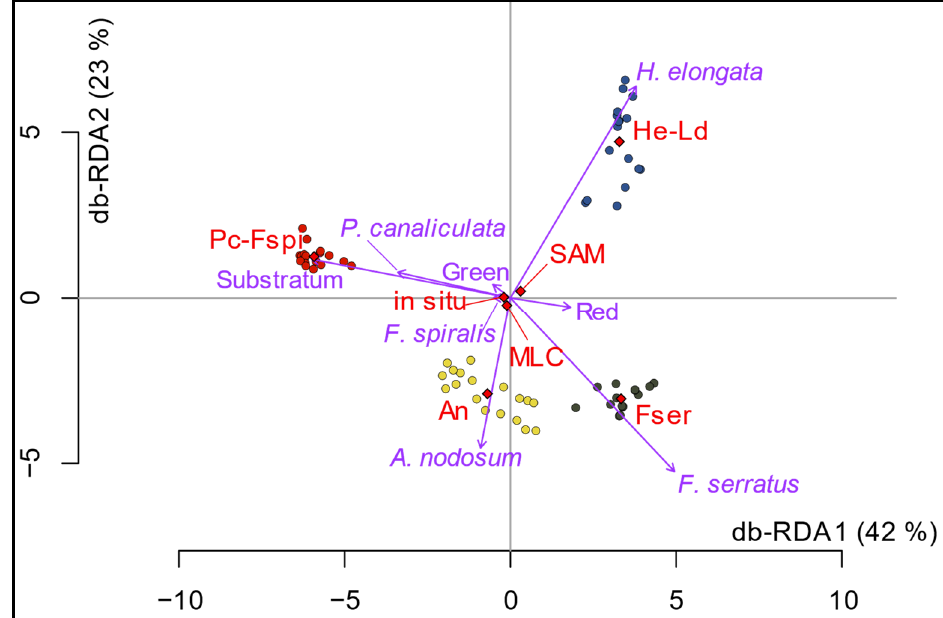
Figure 10. Db-RDA (scaling 1) performed from the macroalgal and pixels covers data for the in situ and the two classifications algorithms. Sampling spots are indicated by circles (Pc-Fspi = red circles, An = yellow circles, Fser = black circles and He-Ld = blue circles), variables (classes used in situ and for classifications: Pelvetia canaliculata , Fucus spiralis , Ascophyllum nodosum , Fucus serratus , Himanthalia elongata , Red, Green and Substratum) appear in purple, and the explanatory variables (level: Pc-Fspi, An, Fser and He-Ld; method: in situ, MLC and SAM) in red.